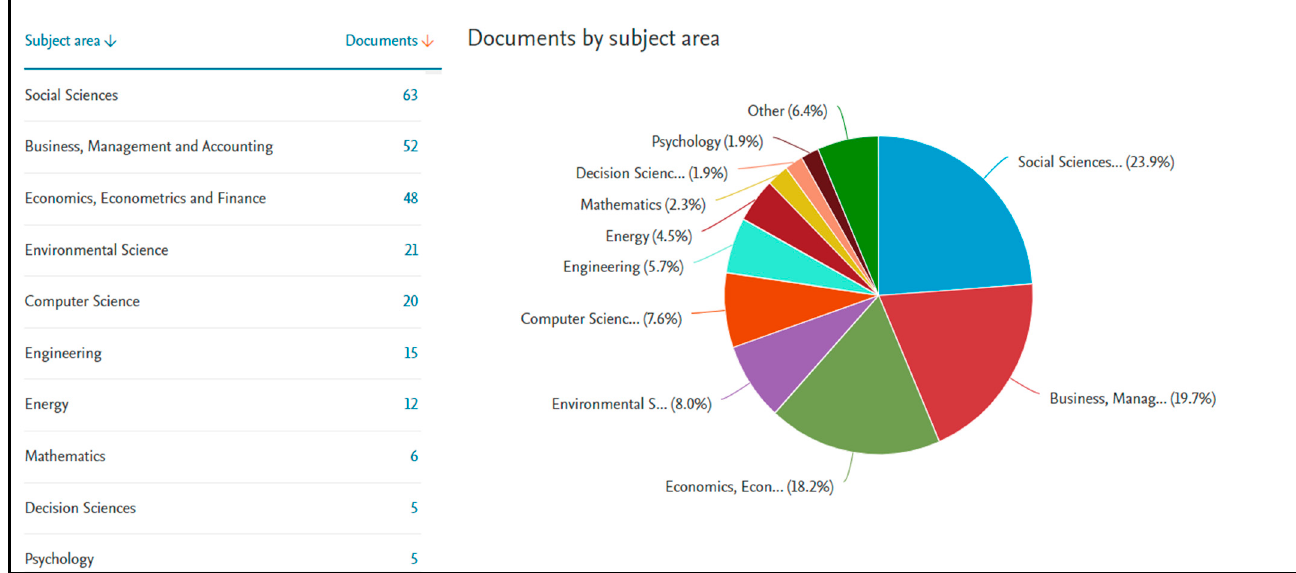
Figure 3. Prominent subject areas.